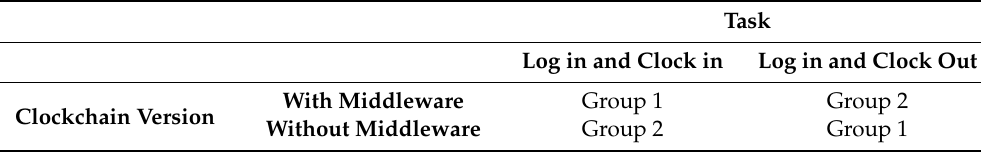
Table 2. Experiment 2 × 2 Factorial Design with Confounded